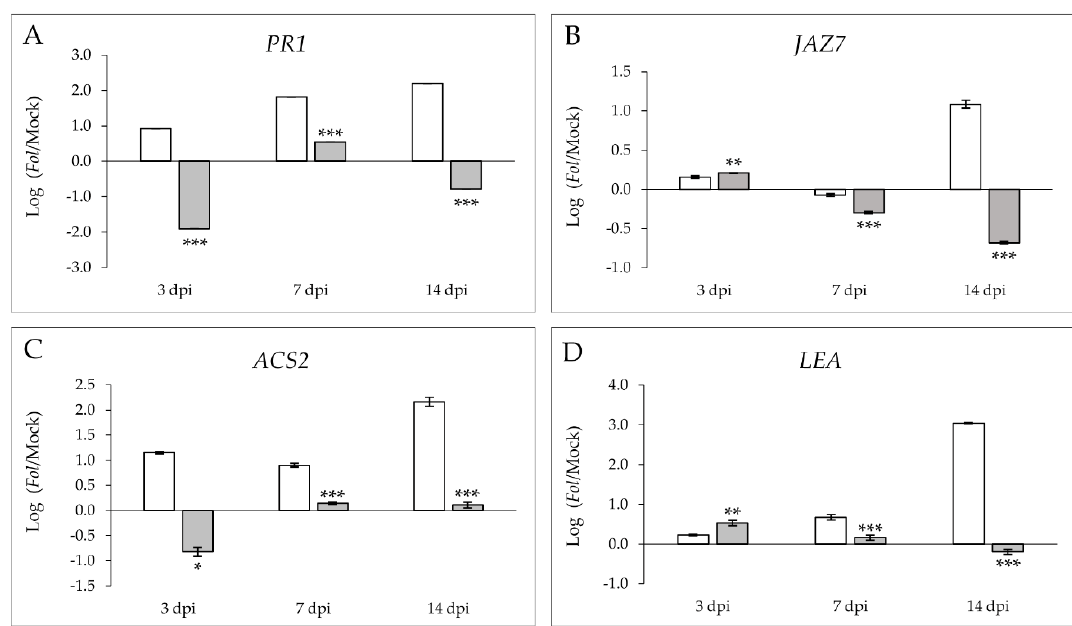
Figure 2. Logarithm of the ratios of the relative expression levels of PR1 ( A ), JAZ7 ( B ), ACS2 ( C ), and LEA ( D ) between Fol -inoculated and mock-inoculated susceptible Momor (MOM, white) and resistant Movione (MOV, gray) tomato plants upon Fusarium oxysporum f. sp. lycopersici infection at 3, 7, and 14 dpi by RT-qPCR. Values obtained were normalized in relation to the elongation factor 1 α (accession X53043.1). cDNA expression levels were expressed as the average log(ratio) values of a representative experiment. Asterisks (*) point out statistical differences between mock-inoculated and Fol -inoculated MOM and MOV plants according to t- test or Mann–Whitney test, with p < 0.05 (*), p < 0.01 (**), and p < 0.001 (***).